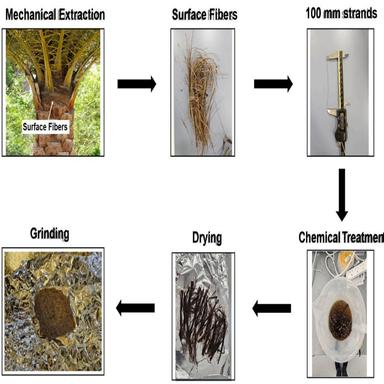
Fiber extraction process through mechanical and chemical methods.